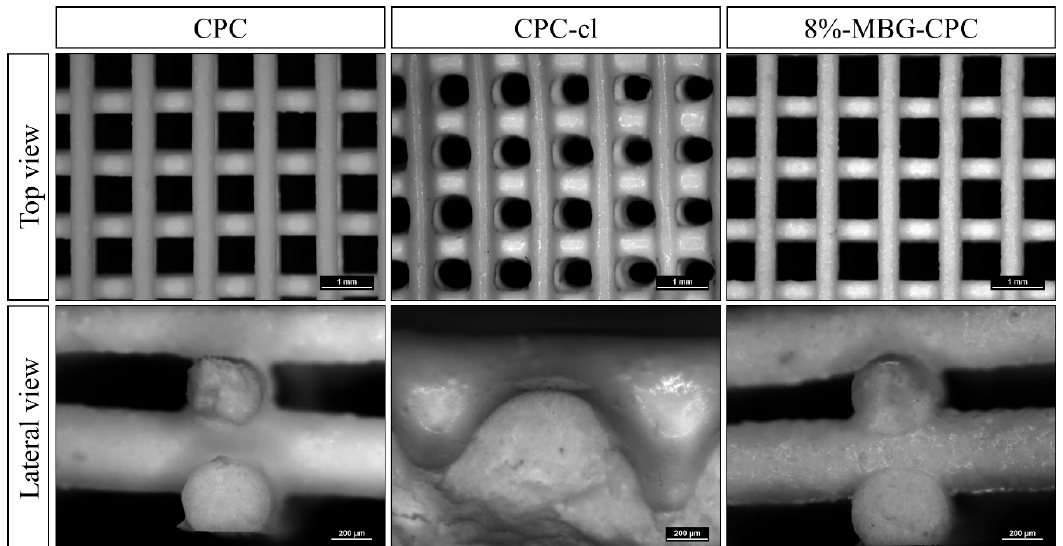
Figure 4. 3D plotted scaffolds from unmodified CPC, CPC with an increased amount of carrier liquid (CPC-cl) and addition of 8% MBG particles and the same amount of carrier liquid. Addition of MBG allowed development of lateral pores without distinct changes compared to MBG-free CPC. Scale bars: Top view 1 mm, lateral view 200 µm.